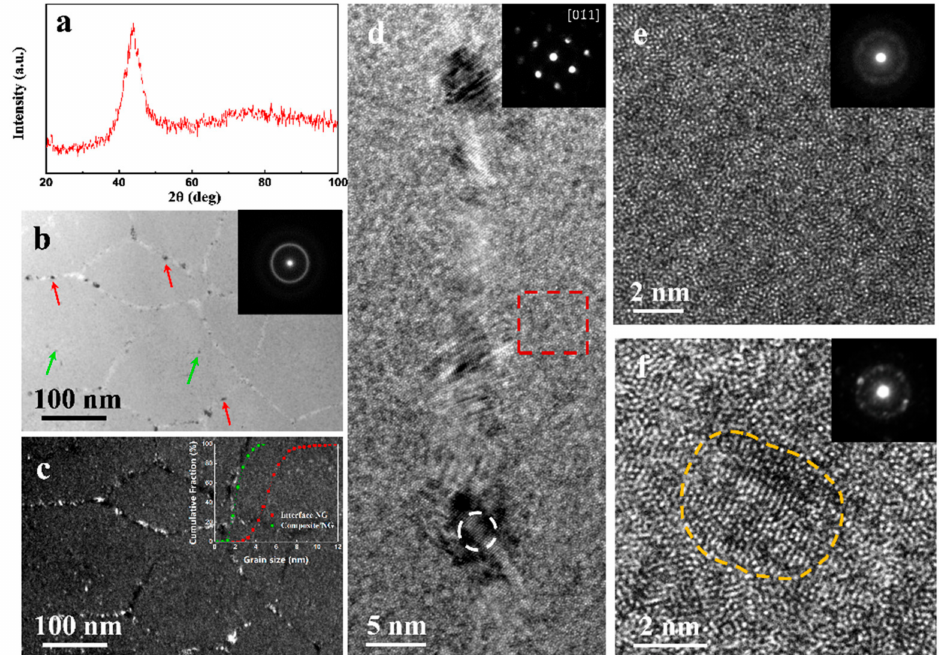
Figure 1. Microstructure of the as-deposited Ni-26Mo alloy. X-ray diffraction pattern ( a ) of the as-deposited Ni-26Mo. Plane view bright field (BF) ( b ) and dark filed (DF) ( c ) TEM images of the as-deposited Ni-26Mo. Insets in ( b , c ) are the corresponding selected area electron diffraction (SAED) and cumulative fraction of grain size of nanograins at nanocrystalline (NC) interfaces and mixed region of NC and amorphous as indicated by red and green arrows in ( b ), respectively. ( d ) A typical high-resolution TEM (HRTEM) image of NC interface with the inset being the nanobeam electron diffraction (NBED) pattern of a nanograin as designated by the white circle. Enlarged HRTEM images of amorphous ( e ) as outlined by red square in ( d ) and NC ( f ) in mixed region of NC and amorphous with the inset being their corresponding NBED